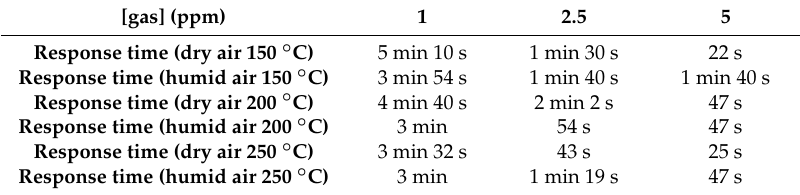
Table 3. Response time of sol-gel GC sensor towards NO 2 at 150, 200 and 250 °C.